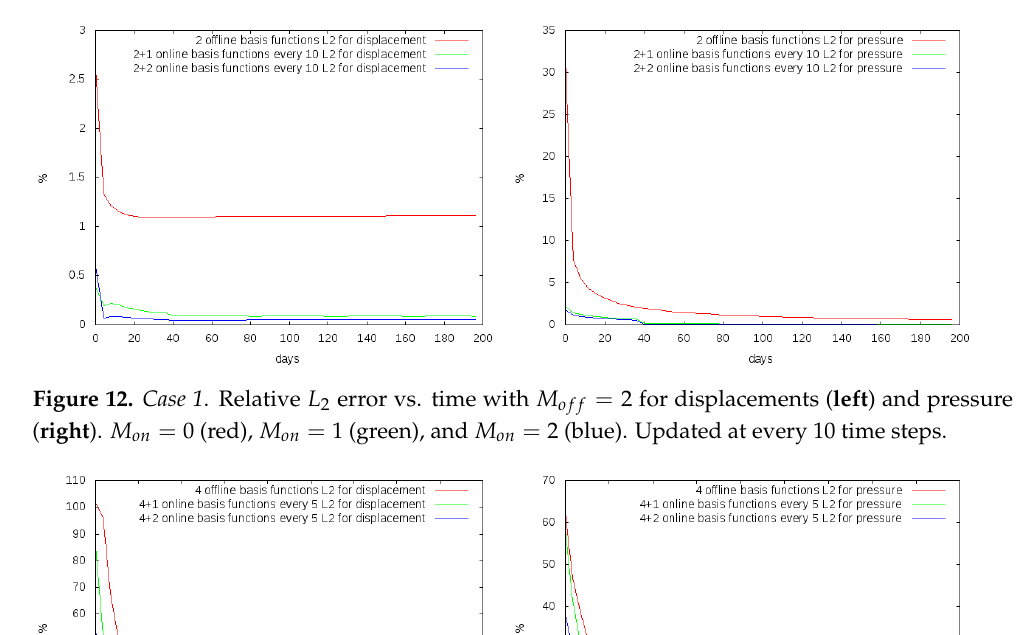
Figure 11. Case 1 . Relative L 2 error vs. time with M of f = 2 for displacements ( left ) and pressure ( right ). M on = 0 (red), M on = 1 (green), and M on = 2 (blue). Updated at every 5 time steps.